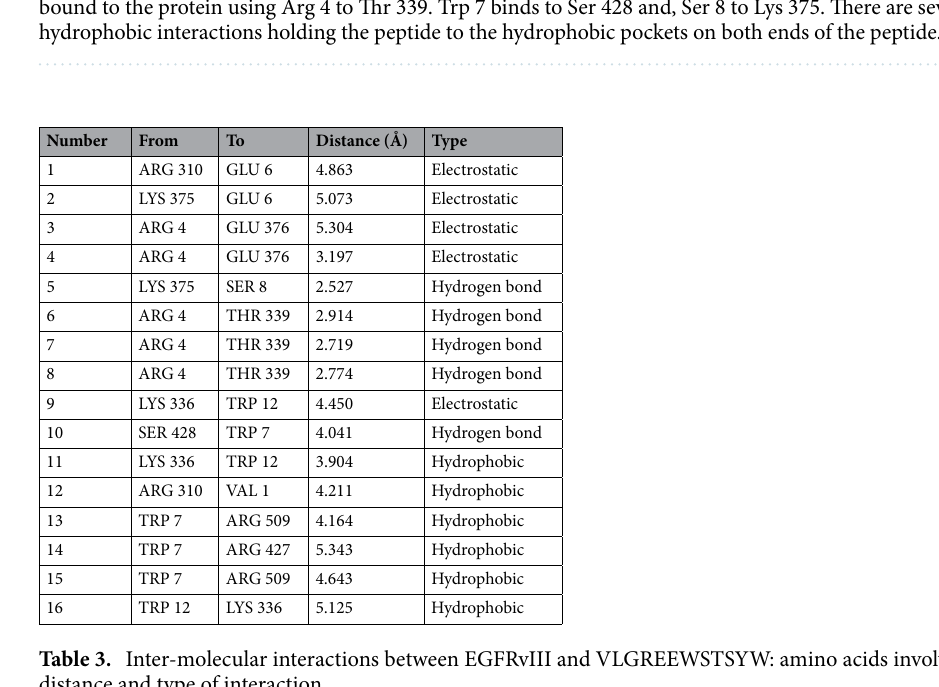
Table 3. Inter-molecular interactions between EGFRvIII and VLGREEWSTSYW: amino acids involved, distance and type of interaction.